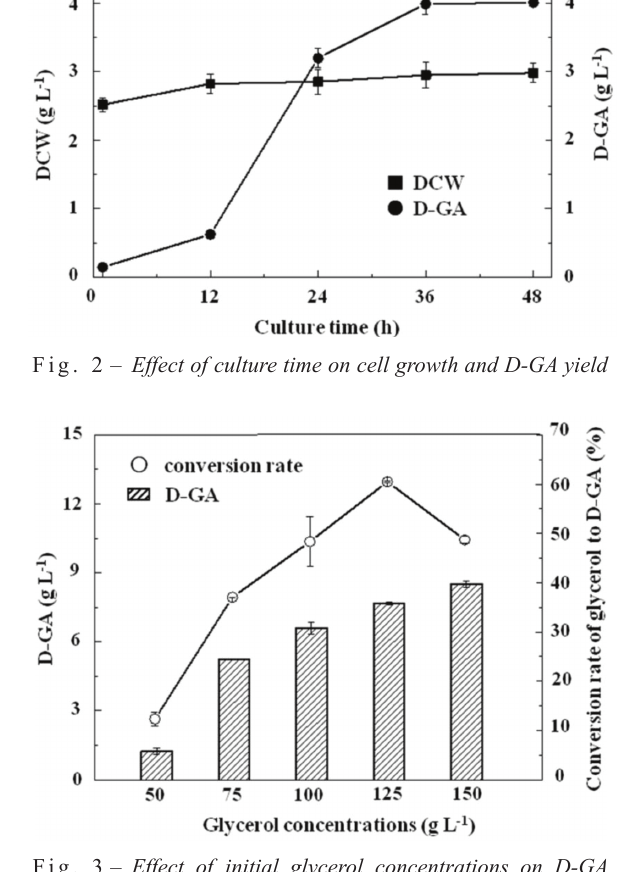
Fig. 3 – Effect of initial glycerol concentrations on D-GA yield in the whole-cell biocatalysis stage. Conversion rate of glycerol to D-GA: D-GA concentration (mol L –1 )/(initial con- centration of glycerol (mol L –1 ) – final concentration of glycer- ol (mol L –1 )) ·100 %.